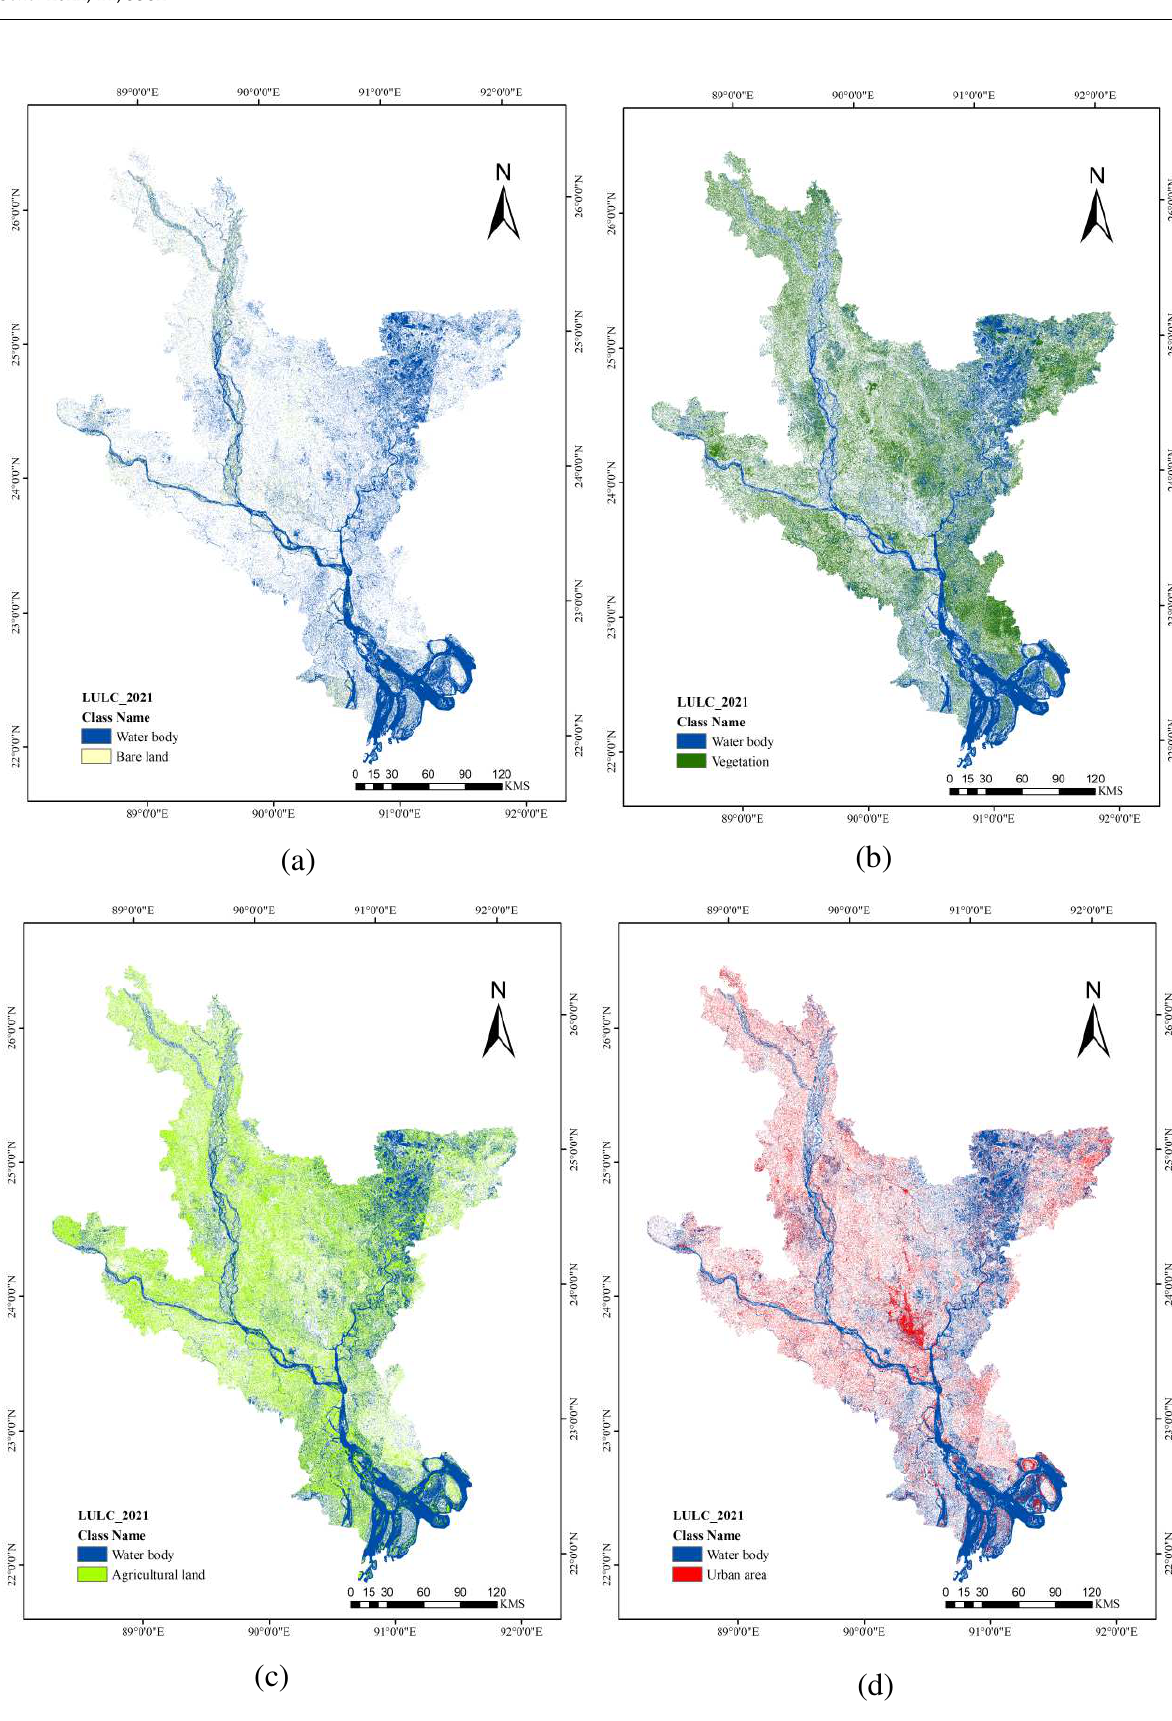
Figure 5. LULC map for different classes with permanent water bodies; ( a ) bare land; ( b ) vegetation; ( c ) agricultural land and ( d ) urban area of 2021.